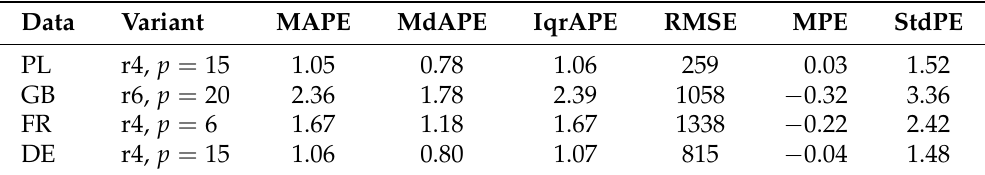
Table 4. Results for test data (training mode: global extended, #trees: 300, minimum leaf size: 1, split predictor selection method: